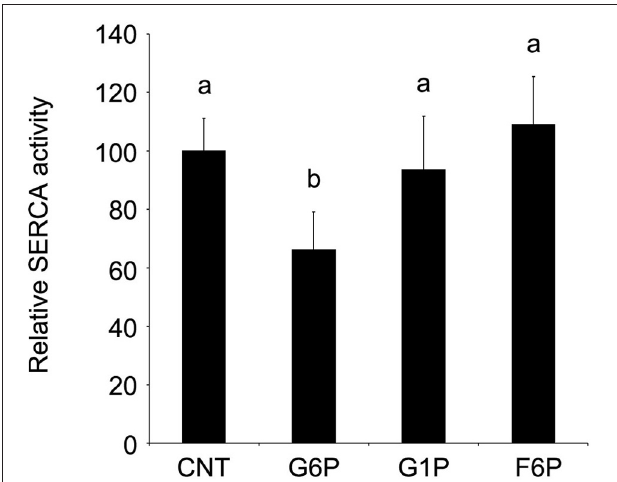
FIGURE 6 | After 6min of incubation, glucose-6-phosphate demonstrated a trend toward reduced accumulation of 45 Ca 2 + in brain ER microsomes. Addition of glucose-6-phosphate (10mM) demonstrated a trend toward reduced accumulation of calcium ( p < 0 . 10), while thapsigargin (1 µ M) reduced ER Ca 2 + accumulation ( p < 0 . 05). When combined, the treatments additively reduced ER Ca 2 + accumulation ( p < 0 . 05) in comparison to control. Data are means ± SEM for n = 5. Each microsomal preparation contained a minimum of eight whole brains pooled together. abc Means with differing superscripts are significantly different, p < 0 . 05, while means that share superscripts are not significantly different.